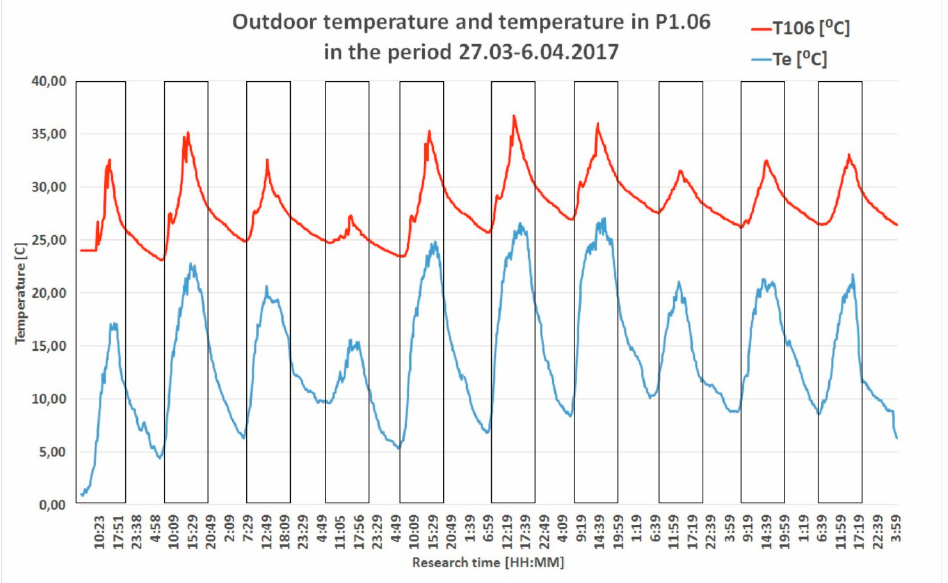
Figure 8. Waveform of outdoor and indoor temperatures in room P1.06—with no venetian blinds installed.